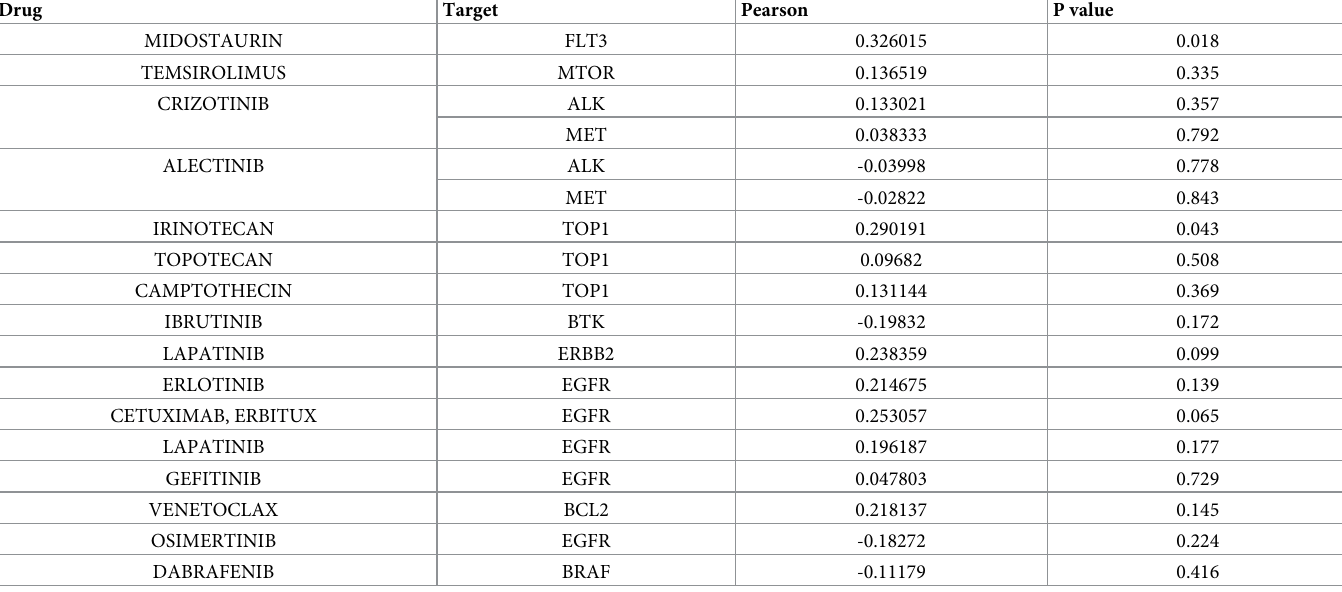
Table 2. Correlation between cell line target gene conservation and targeted drug therapy sensitivities.